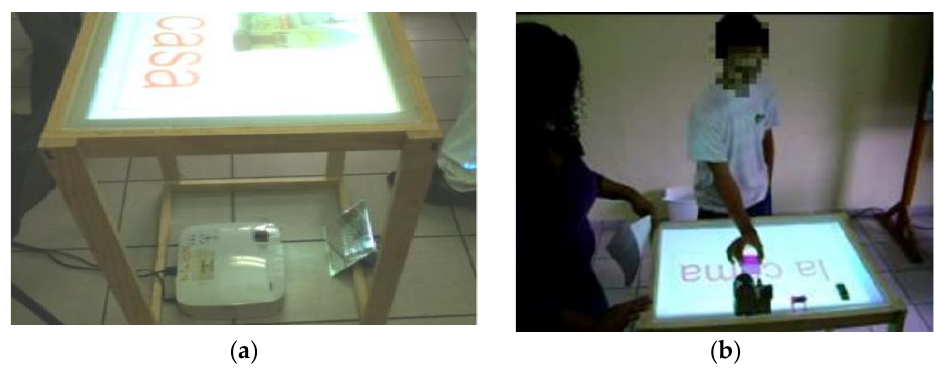
Figure 14. Prototype of tabletop ( a ), User manipulates with tangible object ( b ) [31].